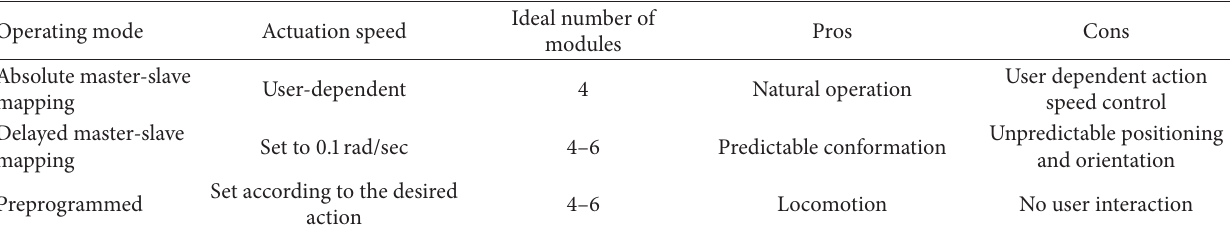
Figure 4: (a) Identical conformation between MCS and mini-robot with slightly different (acceptable) positioning of the second. (b) Identical conformation but very different orientation and positioning. Table 1: Modular remote controlling system operating